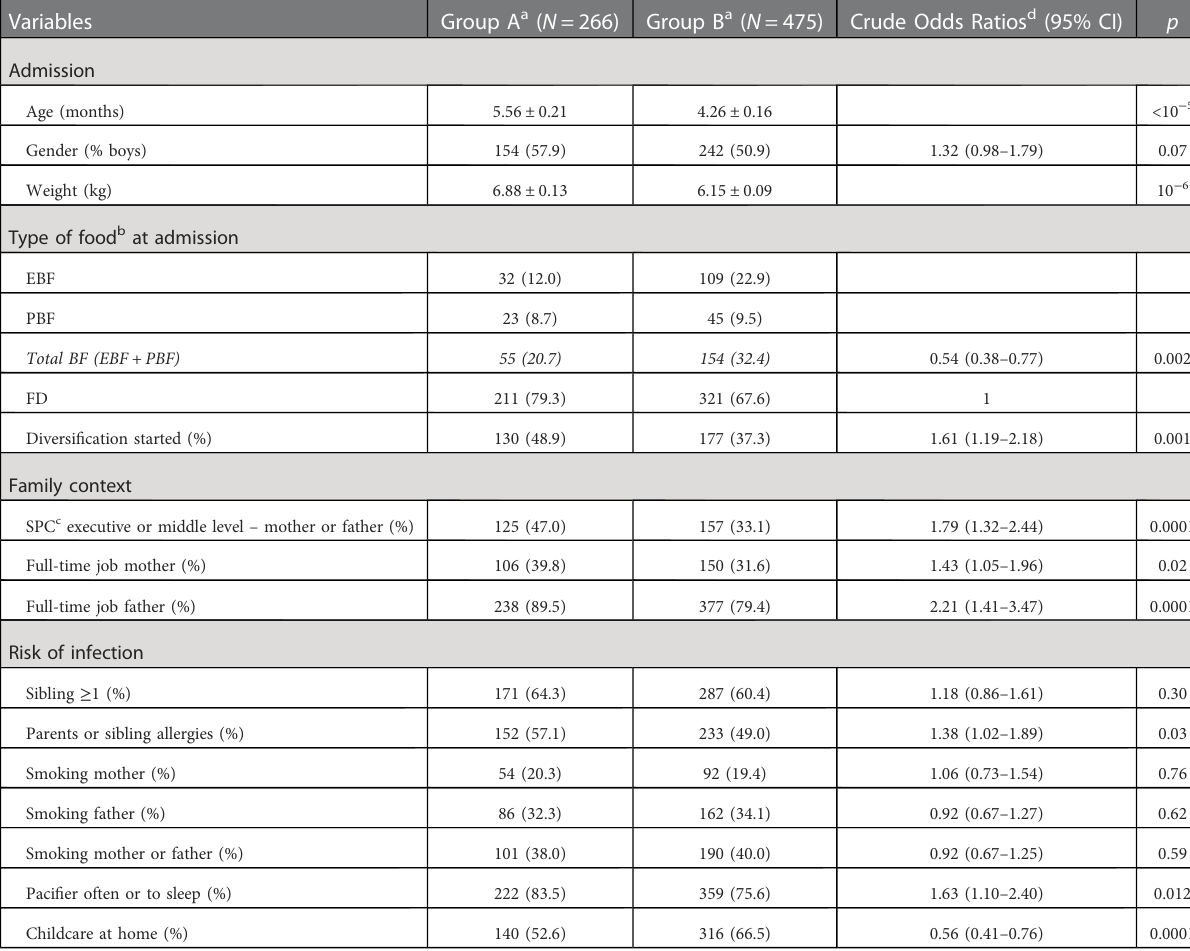
TABLE 2 Comparison between infected children and non-infected children (univariate